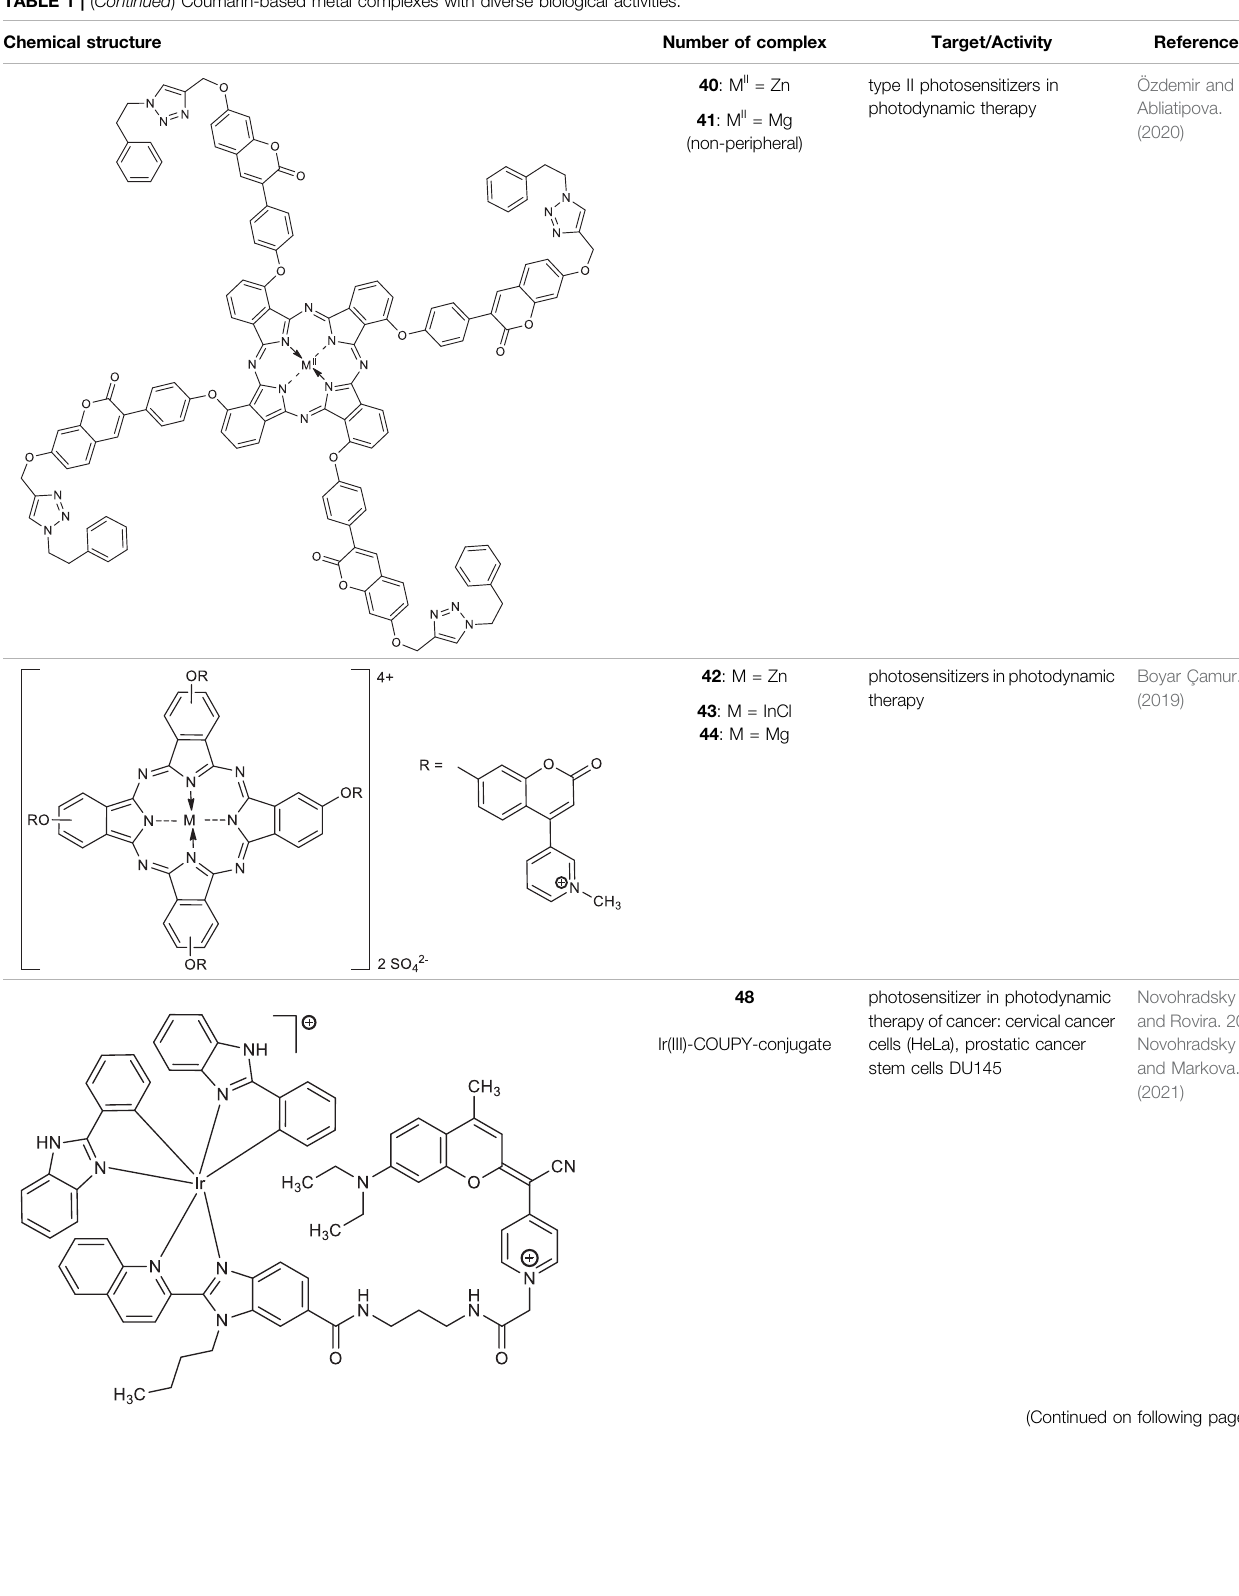
TABLE 1 | ( Continued ) Coumarin-based metal complexes with diverse biological